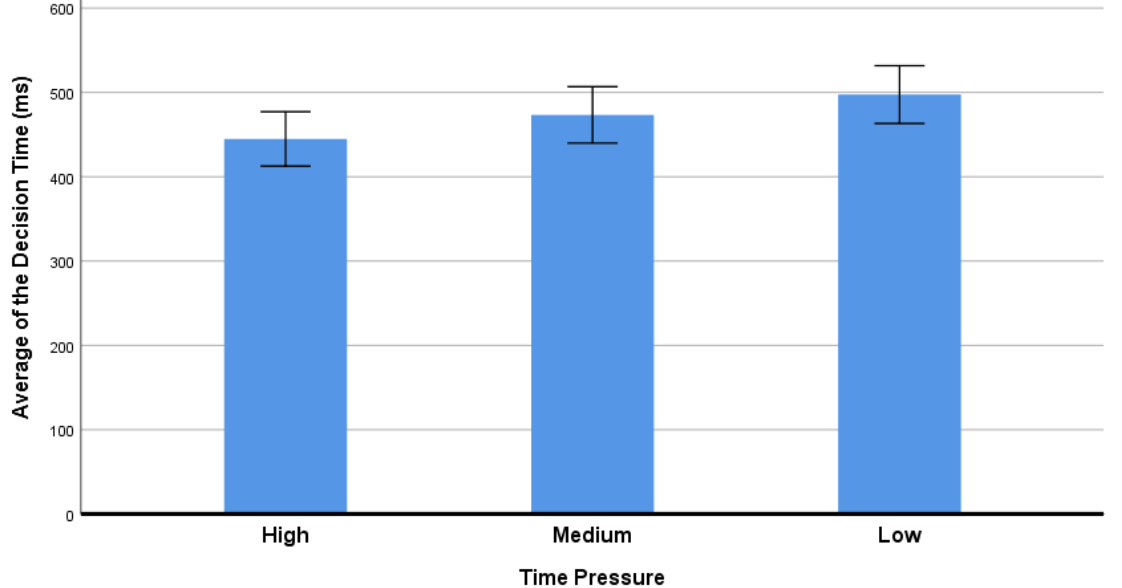
Figure 2. The average decision time of different time pressures. Error bar = 95% confidence interval.